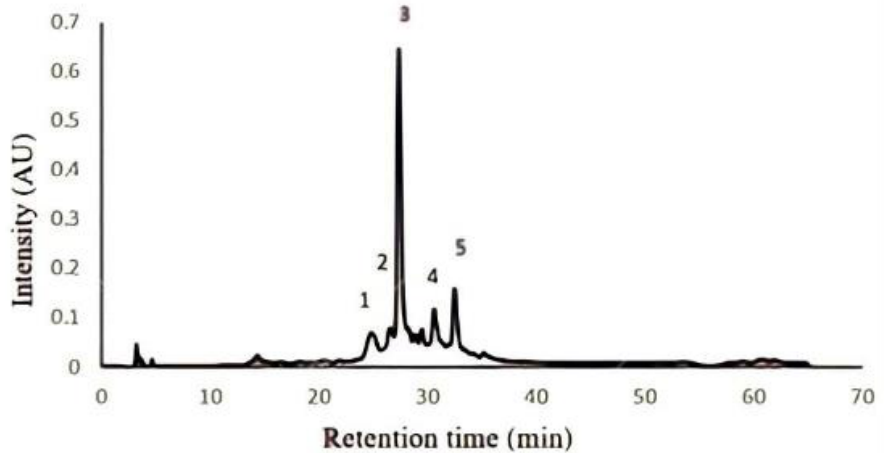
Figure 2. Chromatogram obtained from the HPLC/ESI analysis of the rambutan peel extract. Each